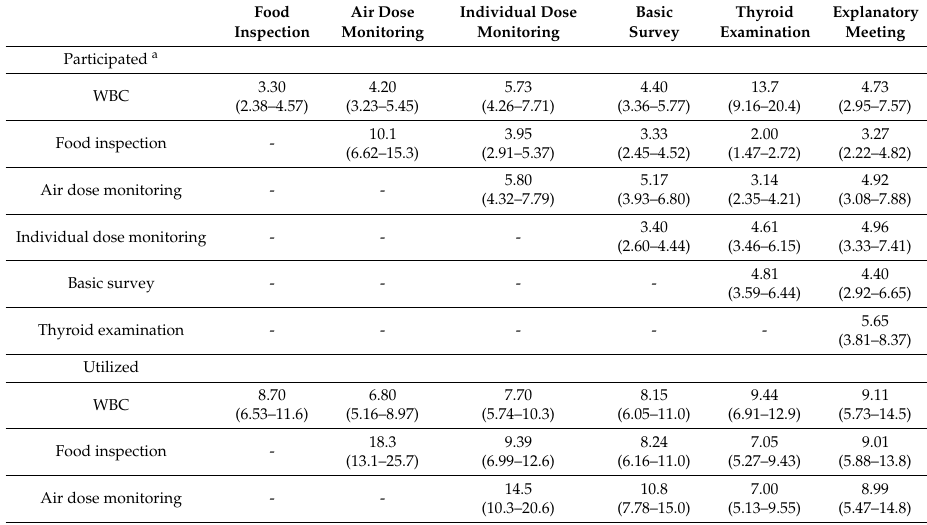
Table 4. Associations of participation between countermeasures and associations of utilization between countermeasures. Values represent odds ratios (95% confidence